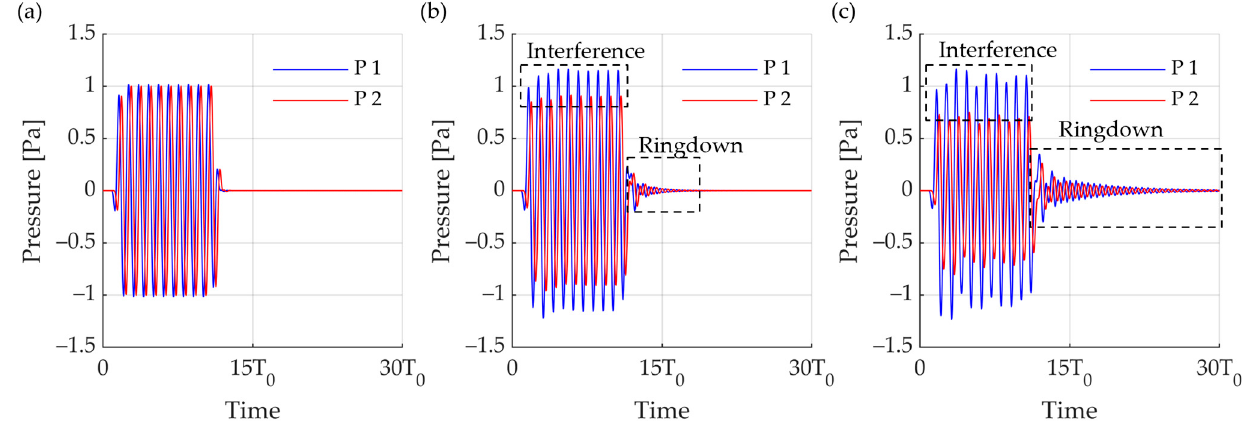
Figure 8. Influence of the material and thickness of the receiving layer on the transmission signal. ( a ) 110 µm PVDF ( b ) 0.5 mm PZT-5A ( c ) 1.0 mm PZT-5A.